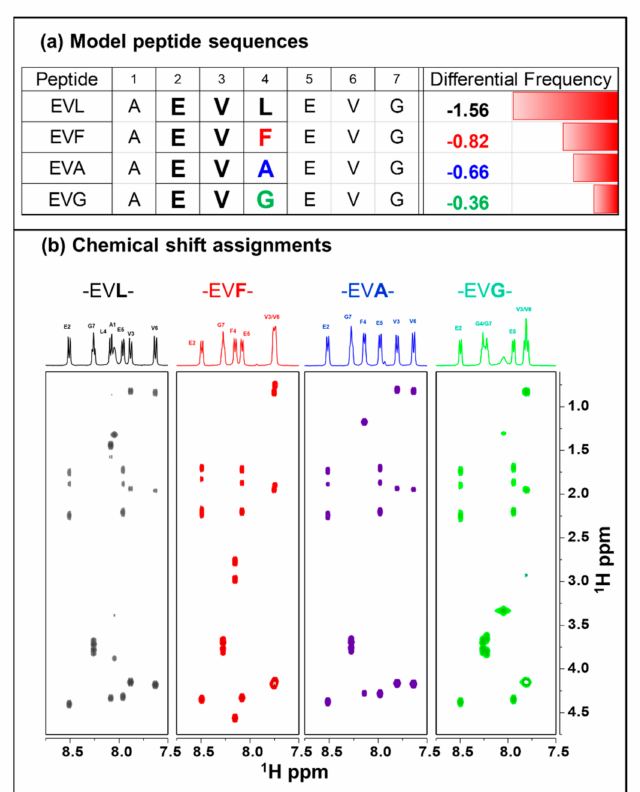
Figure 1. ( a ) List of the model peptides investigated. Heptapeptide sequences a central motif -EVX- with X = L, F, A, or G. For each of the sequences, the corresponding relative frequency of occurrences between globular and transmembrane β -proteins are given. ( b ) Panels of TOCSY spectra of the model -EVX- peptides from left to right: AEVLEVG (black), AEVFEVG (red), AEVAEVG (blue), and AEVGEVG (green). The one-dimensional spectra on the top of each spectrum identify the corresponding chemical shift